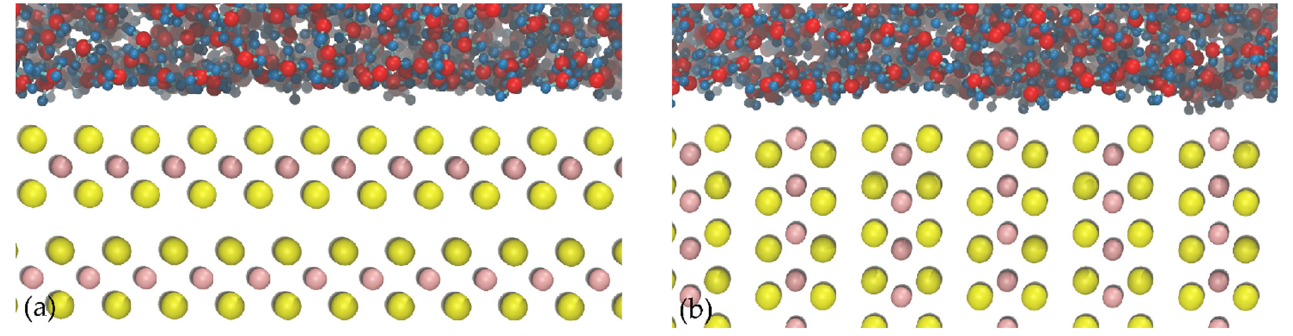
Figure 6. Images of molybdenite/water interfaces: ( a ) molybdenite face; ( b ) molybdenite edge. The atoms’ color codes are as follows: S, yellow; Mo, pink; H, blue; O, red.